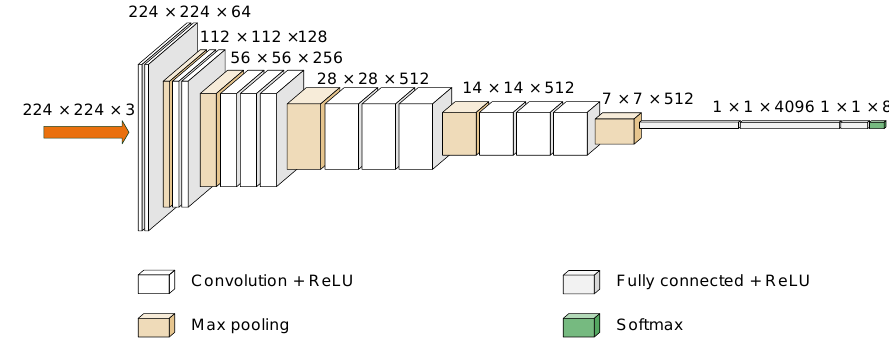
Figure 5. Image of VGG16 architecture with CNN.